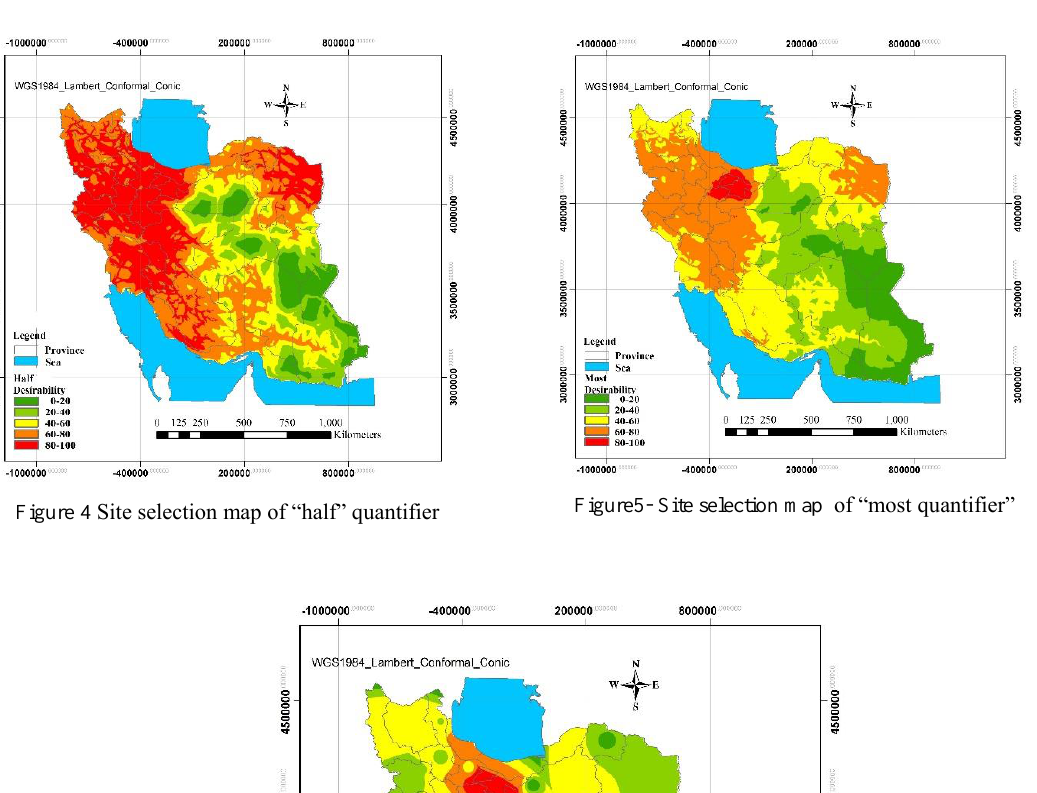
Figure 2 Site selection map of “at least one” quantifier Figure3- Site selection map of “a few” quantifier